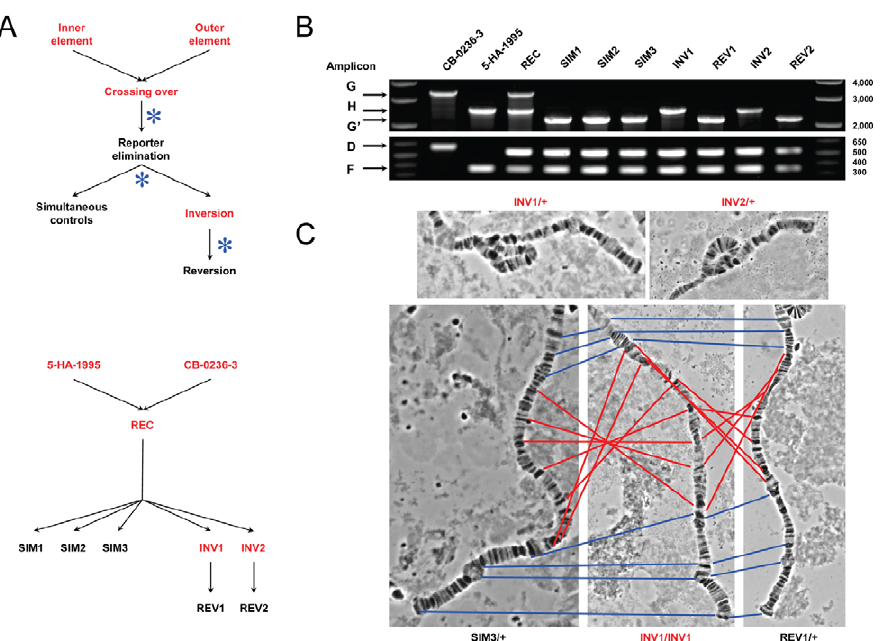
Figure 2. Disruption of the ultraconserved region CG15121 – CG16894 . (A) Outline of the main steps used to obtain the strains carrying the ultraconserved region CG15121 – CG16894 in its disrupted and intact form (Figures S3 and S4 for details). The strains 5-HA-1995 and CB-0236-3 carrying the FRT-bearing TEs [42] were used to induce the inversion In(2R)51F11-56E2 , which disrupts the ultraconserved region (strains INV1 and INV2). Control strains carrying the ultraconserved region in its intact form are also shown (REC, SIM1-SIM3, REV1-REV2; Table S4). Black and red denote w 2 and w + phenotype, respectively; asterisk, heat-shock induced FLP expression. (B) Distinctive banding pattern for the PCR products of five different amplicons (D, F, G/G 9 , H) run simultaneously for each of the strains generated (Material and Methods, Figure S5, and Tables S5 and S6). Two m l from each individual PCR product were combined. Strains 5-HA-1995 and CB-0236-3 show the presence of only one of the FRT-bearing TEs in their genomes while the REC strain shows the presence of both. SIM and REV strains show the successful amplification of the amplicon G 9 , which denotes the presence of a derivative of P{RS3}CB-0236-3 at the outer breakpoint, but not of the amplicon H, indicating that they carry the 2R standard chromosomal arrangement. INV strains show the opposite pattern; the detection of amplicon H denotes the presence of the inverted chromosomal arrangement. (C) Representative polytene chromosome squashes. Top, an inversion loop is observed for the heterozygote progeny of INV1 and INV2 parentals when crossed with individuals from the strain w 1118 thus confirming the presence of the inverted arrangement. Bottom, no inversion loop is observed in the progeny of similar crosses involving SIM3 and REV1. Red and blue lines connect the same polytene band inside and outside of the inverted fragment, respectively, between carriers for the standard arrangement (SIM3 and REV1) and homozygotes for the induced inversion (INV1; center). Apart from the inversion In(2R)51F11-56E2 in the strains INV1 and INV2, no other gross chromosome alteration was detected for the strains shown in